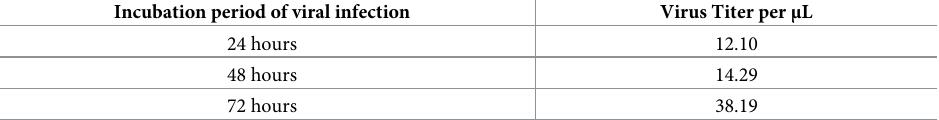
Table 2. Virus titer of Vero cells infected with the SARS-CoV-2 virus isolates at a multiplicity of infection (MoI) of 0.04 at 24, 48, and 72 hours post